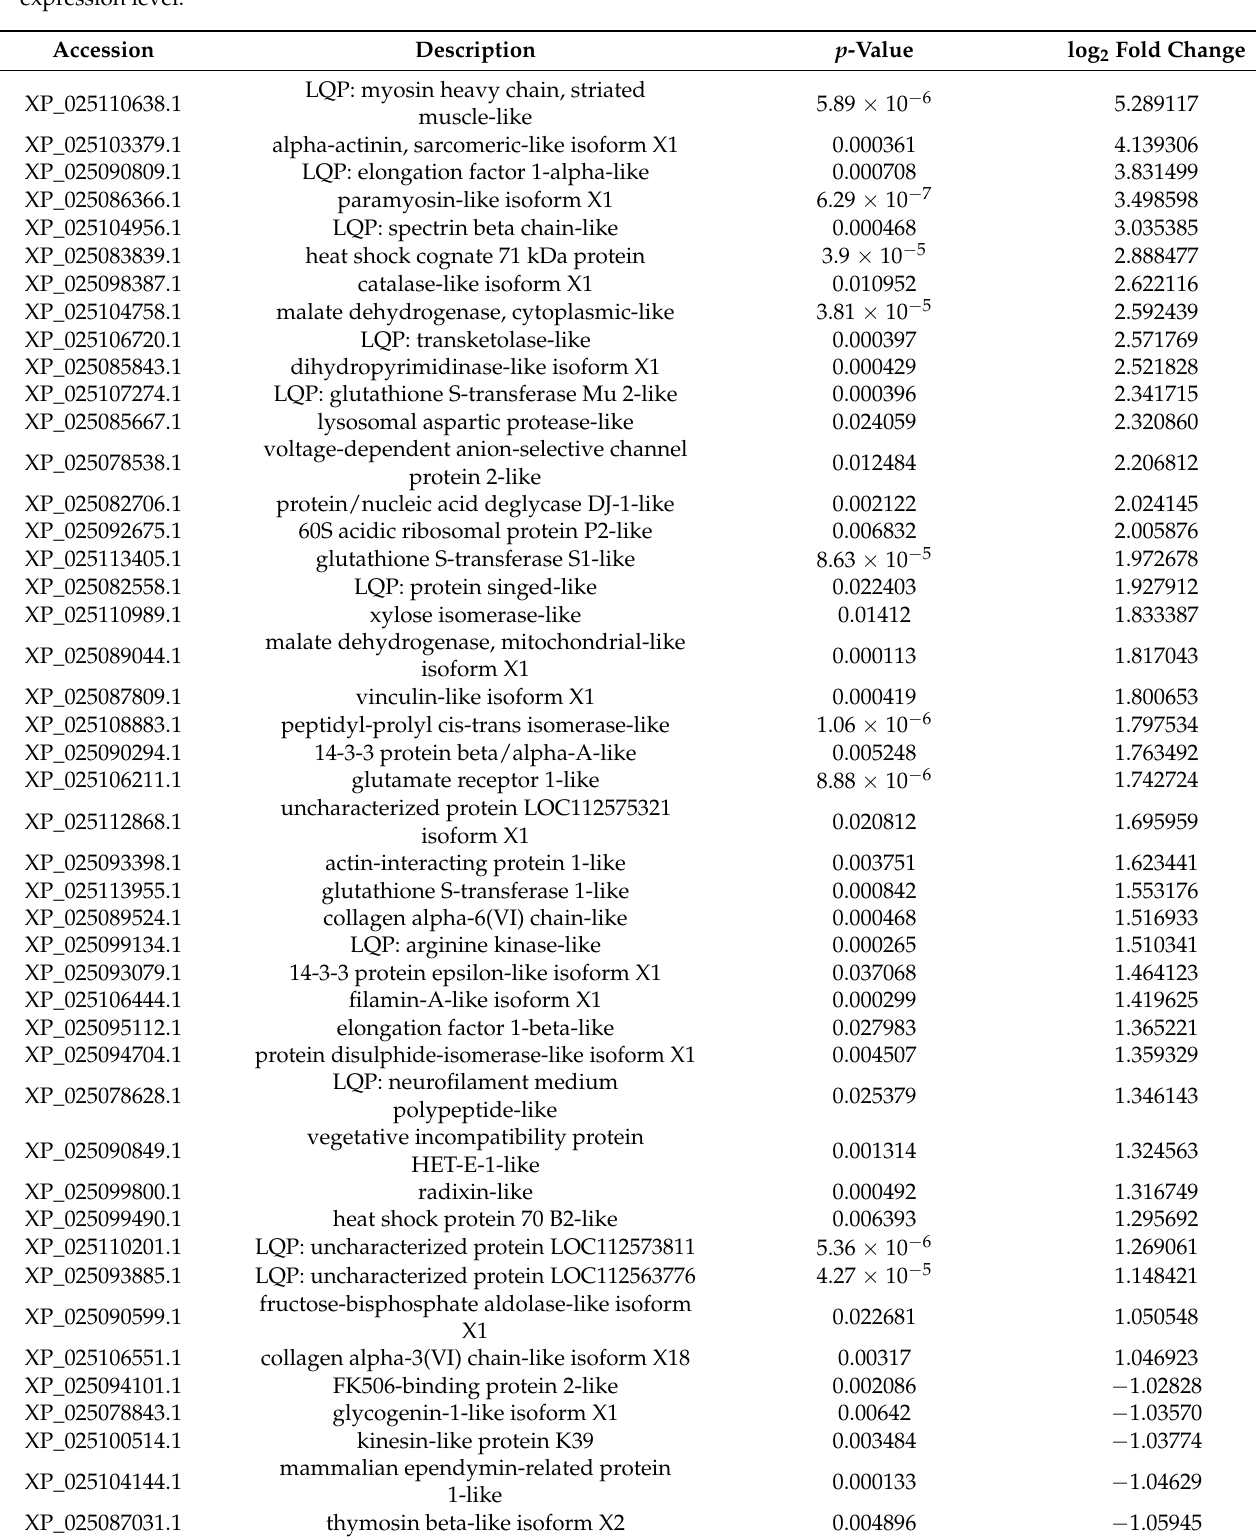
Table 2. Common proteins between ampullae exposed or not exposed to the nematode with a significantly different expression